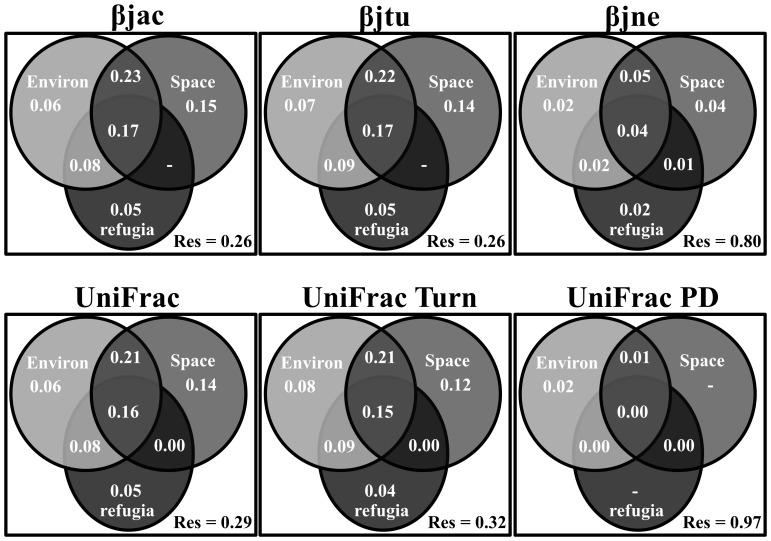
Partition of the variance of Compositional Beta Diversity (CBD, βjac, βjtu and βjne) and Phylogenetic Beta Diversity (PBD, UniFracTotal, UniFracTurn and UniFracPD) components explained by geographical distance (Space), current environmental gradients (Environ) and long-term climatic conditions (refugia) for 44 sites in the southern range of Brazilian Atlantic Forest.Res  =  unexplained variance. “-”  =  variation explained <0.